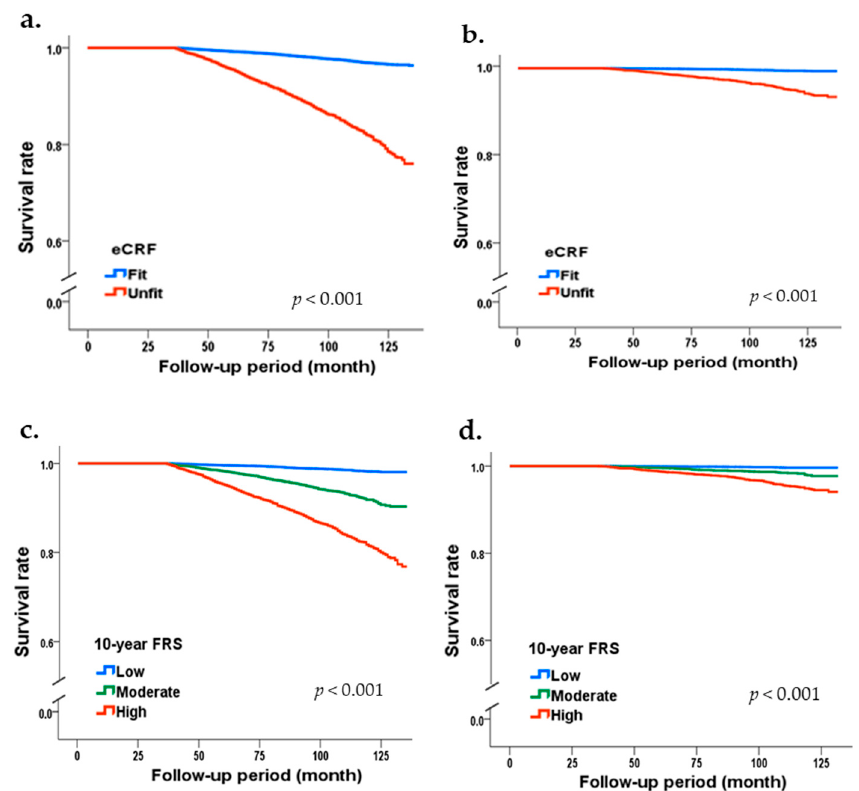
Figure 2. The Kaplan–Meier survival curves for all-cause and cardiovascular disease (CVD) mortality by estimated cardiorespiratory fitness (eCRF) and 10-yr Framingham risk score (FRS): ( a ) eCRF and all-cause mortality; ( b ) eCRF and CVD mortality; ( c ) FRS and all-cause mortality, and ( d ) FRS and CVD mortality. Table 4 represents HRs and 95% CI for all-cause and CVD mortality by eCRF and FRS. There were significant interaction effects between eCRF and FRS on all-cause and CVD mortality in all models ( p < 0.001 and p < 0.001, respectively). With respect to